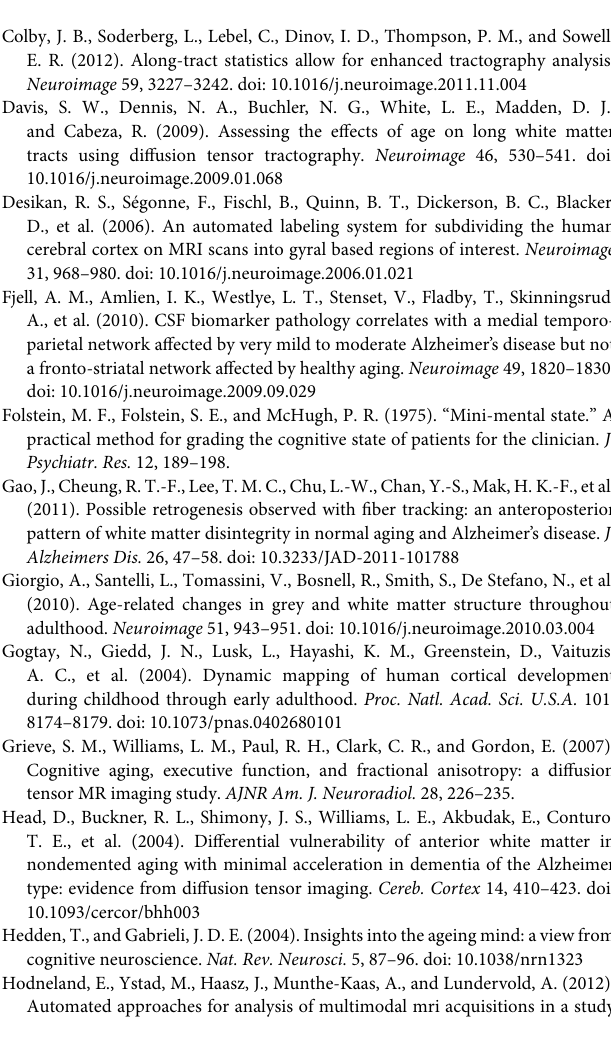
Supplementary Figure 1 | Two-wave tract parameterization analysis for the remaining 9 subcortical-frontal fibers where mean FA was substantially reduced. (A) LH caudate, lateral orbitofrontal; (B) RH thalamus, rostral middle frontal; (C) RH putamen, lateral orbitofrontal; (D) LH caudate, medial orbitofrontal; (E) RH caudate, lateral orbitofrontal; (F) RH putamen, pars triangularis; (G) LH caudate, rostral middle frontal; (H) RH caudate, medial orbitofrontal; (I) RH putamen, lateral orbitofrontal. For more detailed figure description see Figure 2 . Supplementary Figure 2 | Two-wave tract parameterization analysis for the remaining 9 subcortical-frontal fibers where mean FA was preserved. (A) LH thalamus, superior frontal; (B) LH putamen, medial orbitofrontal; (C) LH Putamen, rostral middel frontal; (D) LH thalamus, rostral middle frontal; (E) LH putamen, lateral orbitofrontal; (F) LH putamen, lateral orbitofrontal; (G) LH caudate, superior frontal; (H) LH putamen, pars triangularis; (I) LH accumbens, medial orbitofrontal. For more detailed figure description see Figure 2